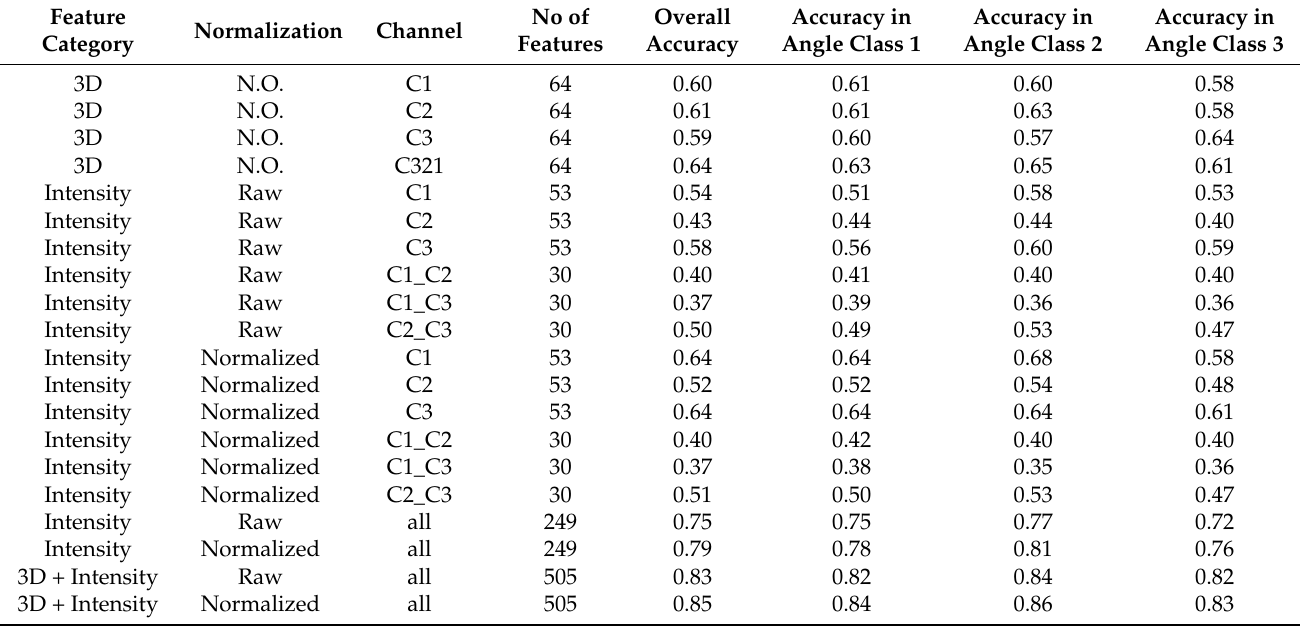
Table A4. Comparison of the classification accuracy capability of different feature categories as a function of scan angle